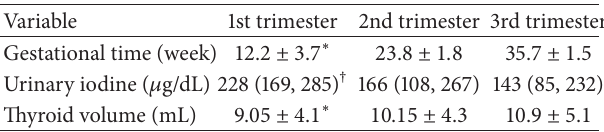
Table 1: Average trimester specific values of gestational age, urinary iodine concentration and thyroid volumes in 152 healthy pregnant women.